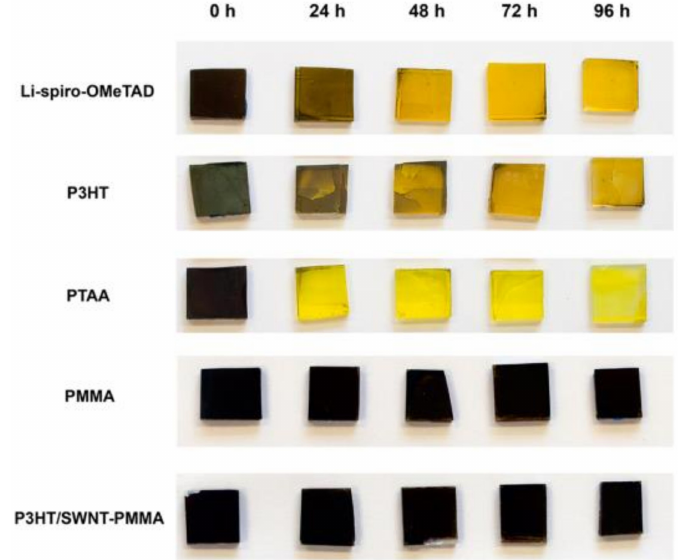
Figure 13. Visible degradation photographs of perovskite films covered with di ff erent hole transport materials, including the Li-spiro-OMeTAD, P3HT, PTAA, PMMA and P3HT / SWNT-PMMA (reproduced from Reference [211] with permission, copyright American Chemical Society,